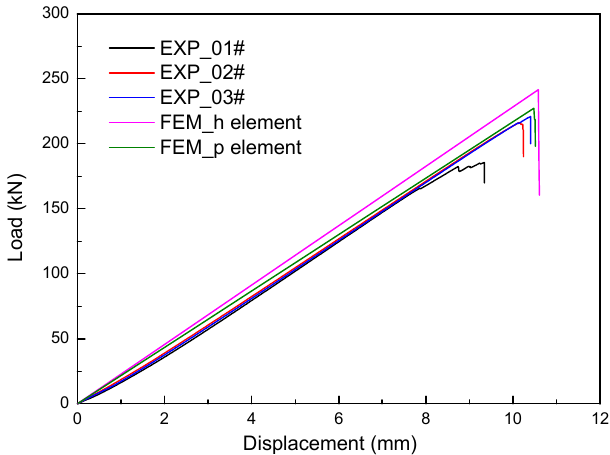
Figure 13. Shear load vs. displacement curves obtained by experimental and numerical methods.